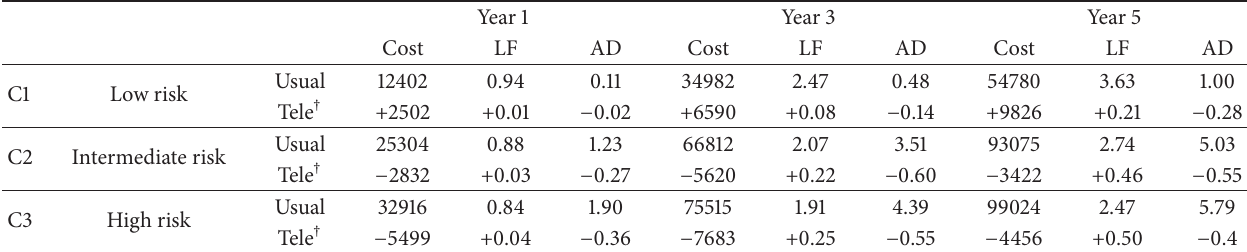
Table 5: Base case results.